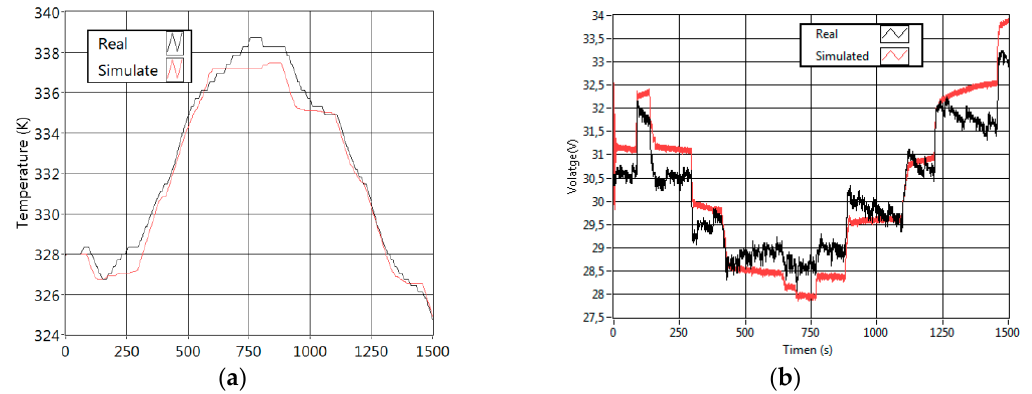
Figure 8. Simulation with the identified parameters using the profile of current 1. ( a ) Stack temperature; ( b ) output voltage.